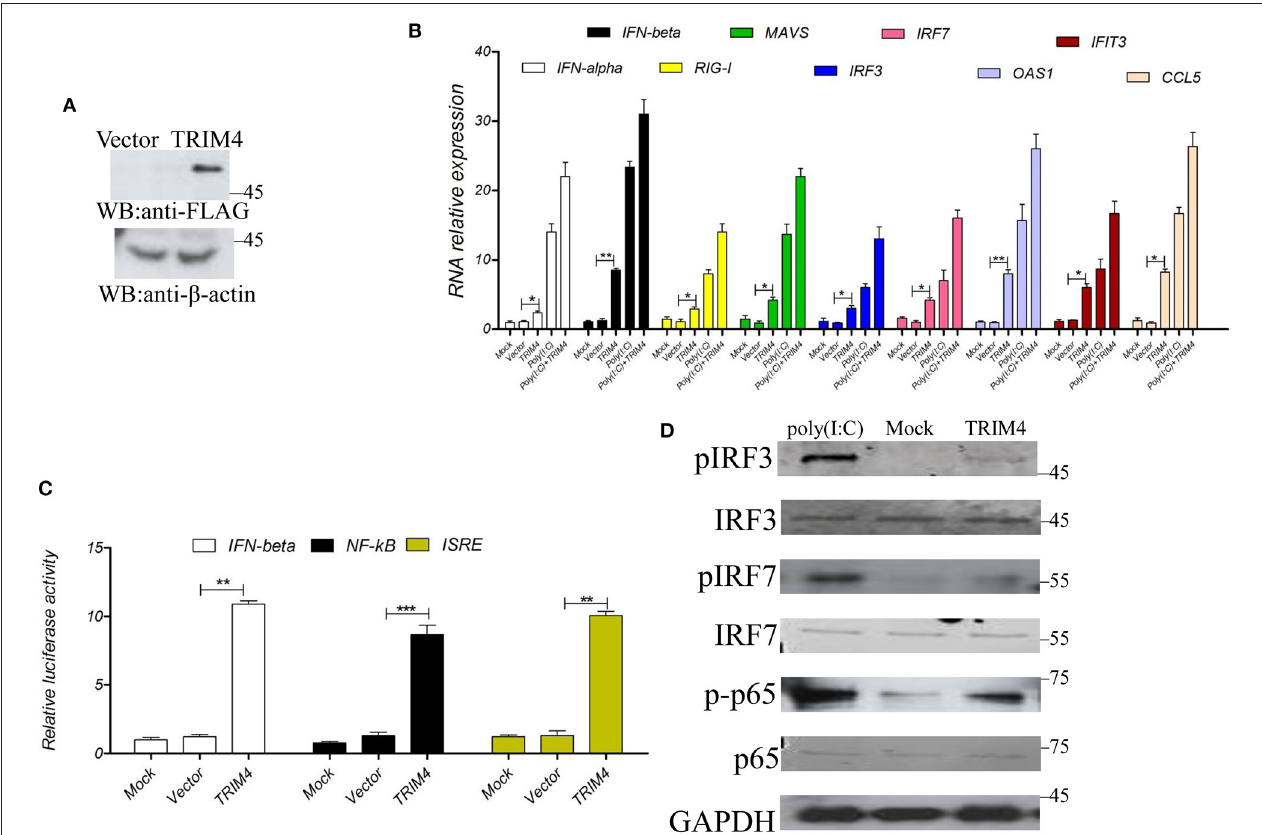
FIGURE 1 | Macaca mulata TRIM4 overexpression activates the interferon (IFN) pathway. (A) The TRIM4 plasmid was transfected into MARC145 cells. After 48h, western blotting was performed with the indicated antibody. (B) After TRIM4 transfection in MARC145 cells, RNA was extracted 24h post-transfection. At the